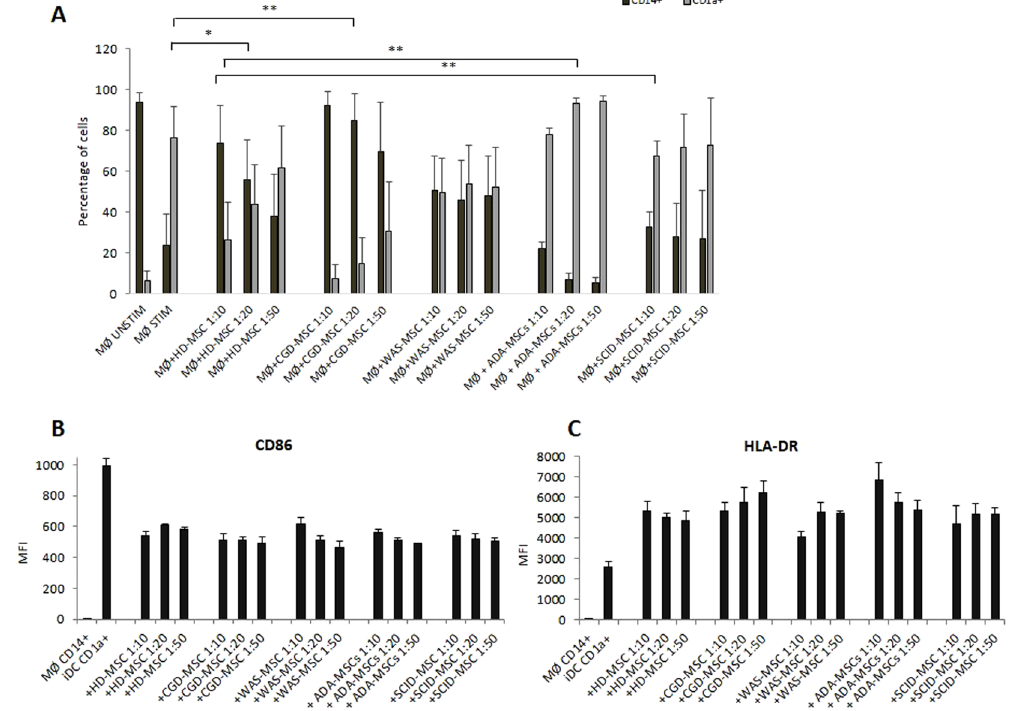
Figure 4. In vitro immunomodulatory effect of HD- and PID-MSCs on monocyte (MØ) maturation into immature dendritic cells (iDCs) isolated from HDs. ( A ) The graph shows the percentage of MØ (CD14 + , black bars) and DCs (CD1a + , grey bars) co-cultured in the presence or in the absence of MSCs in a medium additioned with interleukin 4 (IL-4) and granulocyte macrophage-colony stimulating factor (GM-CSF). Each bar represents the percentage of residual proliferation of 10 5 MØ, in the presence of three different MSC:MØ ratios (MSC:MØ ratio of 1:10, 1:20 and 1:50). After 7-day co-culture, cells were collected, stained for CD14 and CD1a and analyzed by flow-cytometry. Mean ± SEM of multiple experiments (7 HD-MSCs, 7 CGD-MSCs, 8 WAS-MSCs, 5 ADA-MSCs and 5 SCID-MSCs were tested at least twice and each point being in triplicate) is reported. P values lower than 0.05 were considered to be statistically significant ( * p < 0.05; ** p < 0.01). ( B , C ) Expression of CD86 (B) and HLA-DR (C) on MØ co-cultured in the presence and in the absence of MSCs in a medium additioned with IL-4 and GM-CSF, evaluated as MFI (mean fluorescence intensity) for 3 HD-MSCs, 3 CGD-MSCs, 3 WAS-MSCs, 3 ADA-MSCs and 3 SCID-MSCs samples. Each bar represent the mean ±